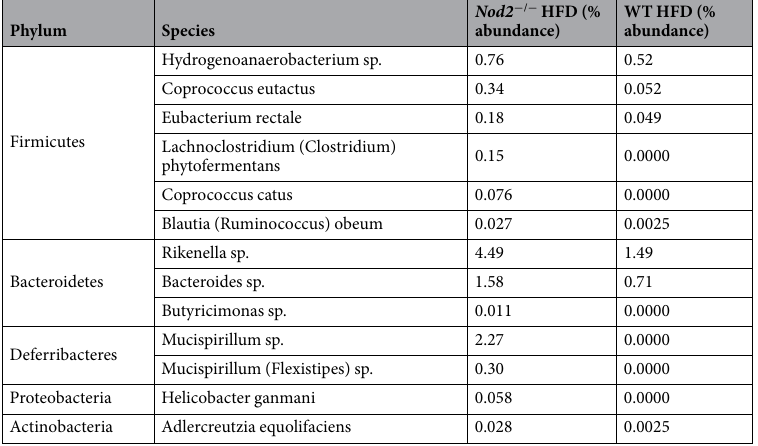
Table 1. Bacterial species with significantly higher abundance in Nod2 − / − HFD mice than in WT HFD mice * . * P < 0.05 for all species. The entire microbiome analysis data comparing bacterial diversity in the stools of WT and Nod2 − / − mice maintained on HFD and LFD have been deposited in NCBI SRA, accession No.